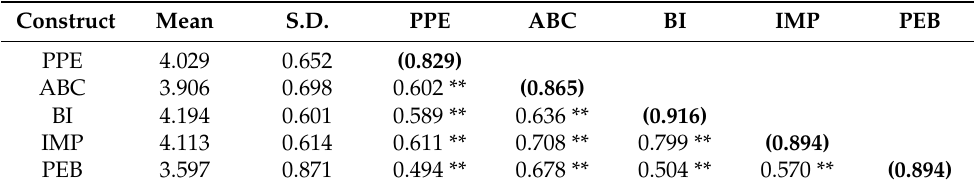
Table 5. Means, standard deviations, reliabilities, and